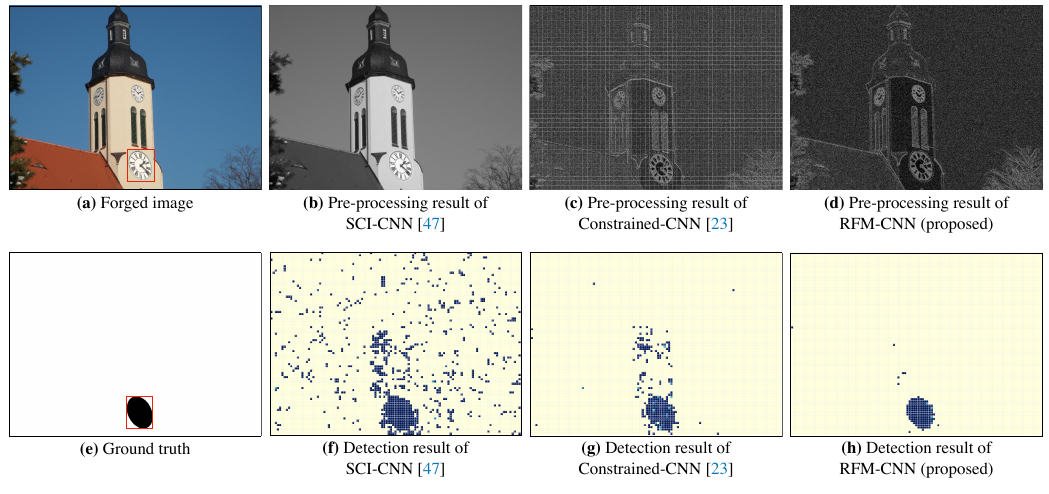
Figure 6. Tampering localization with different pre-processing stages: ( a ) forged image; ( e ) ground truth; ( b ) SCI-CNN denoting grayscale input image without pre-processing operation; ( c ) Constrained-CNN; ( d ) RFM-CNN with pre-processing operation; ( f – h ) visualization results generated by different